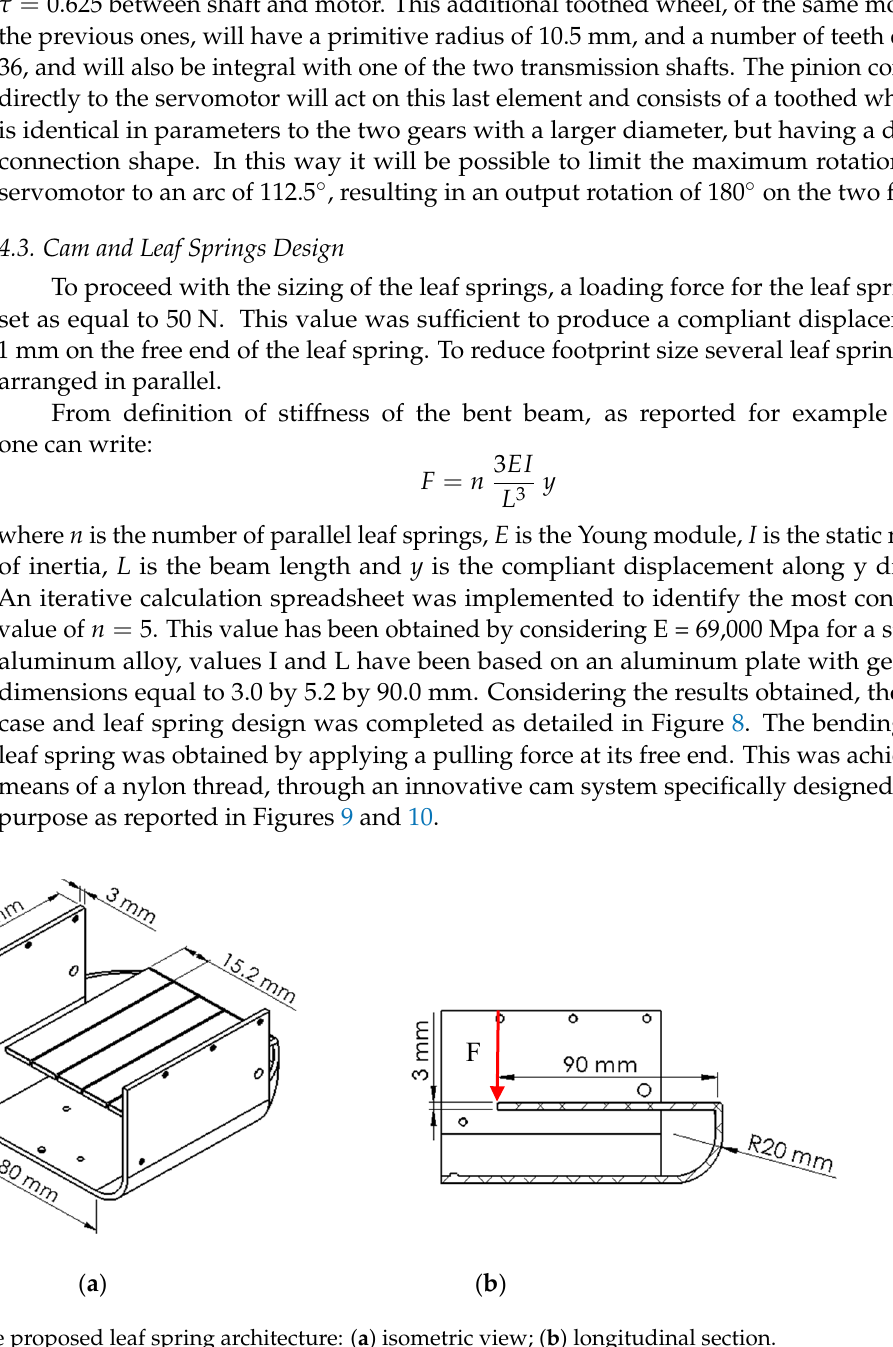
Figure 8. The proposed leaf spring architecture: ( a ) isometric view; ( b ) longitudinal section.